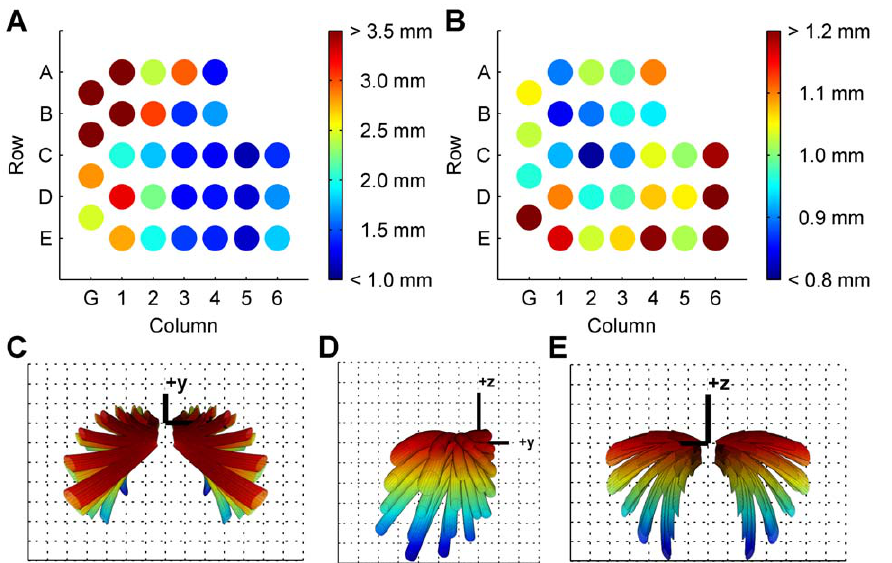
Figure 10. Error in whisker position. ( A ) Standard error (mm) at each whisker tip. ( B ) Standard error (mm) at each whisker base. ( C–E ) Horizontal, sagittal, and coronal views of the final model with error surfaces surrounding each whisker. The error cylinder radius at each arc length is equal to the 95% confidence interval based on the propagated standard deviation and assuming a normal distribution of errors. Colors in C–E are visual aids only; they do not represent error.